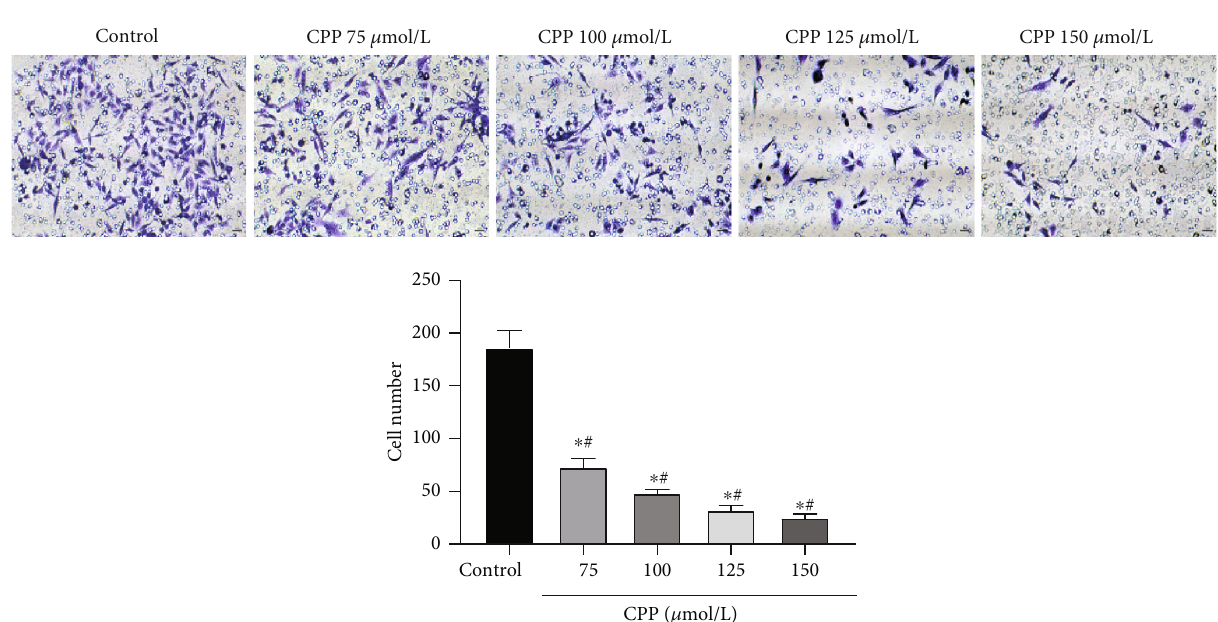
Figure 6: CPP treatment inhibits the invasion of U251 cells. Compared with the control group, ∗ indicates p < 0 : 05 . Comparison between treatment groups with di ff erent concentrations of CPP (75, 100, 125, and 150 μ mol/L), # indicates p < 0 : 05 . The experiment was repeated three times